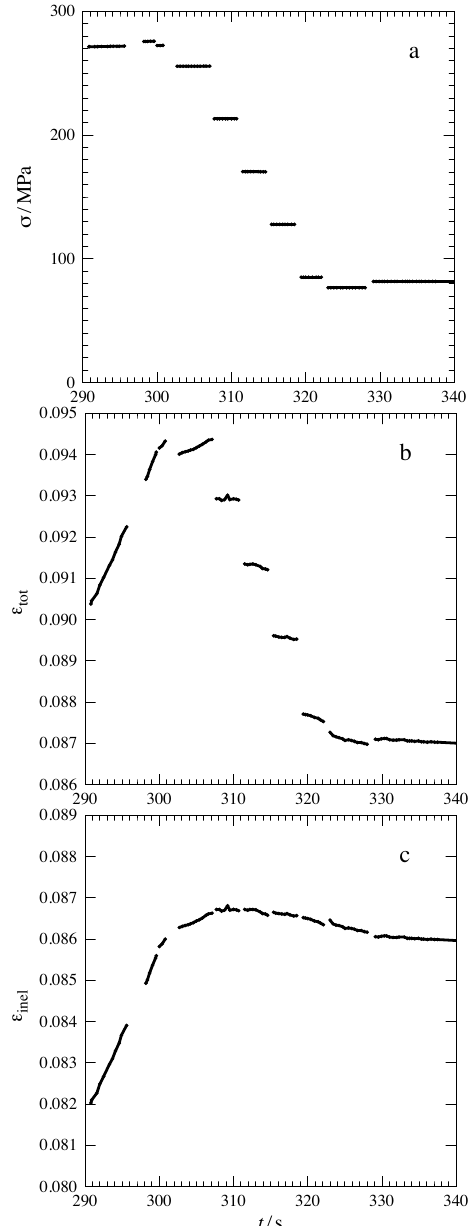
Figure A1. ( a ) Stress σ , ( b ) total strain (cid:101) tot with elastic strains from machine and specimen, ( c ) inelastic strain (cid:101) inel versus time t in load change test on 8Cu–Zr at